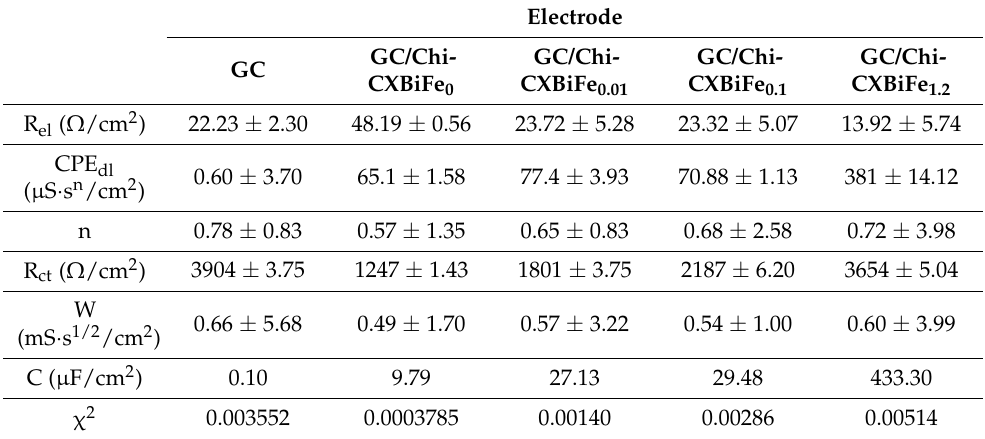
Table 3. The parameters of the equivalent circuit.